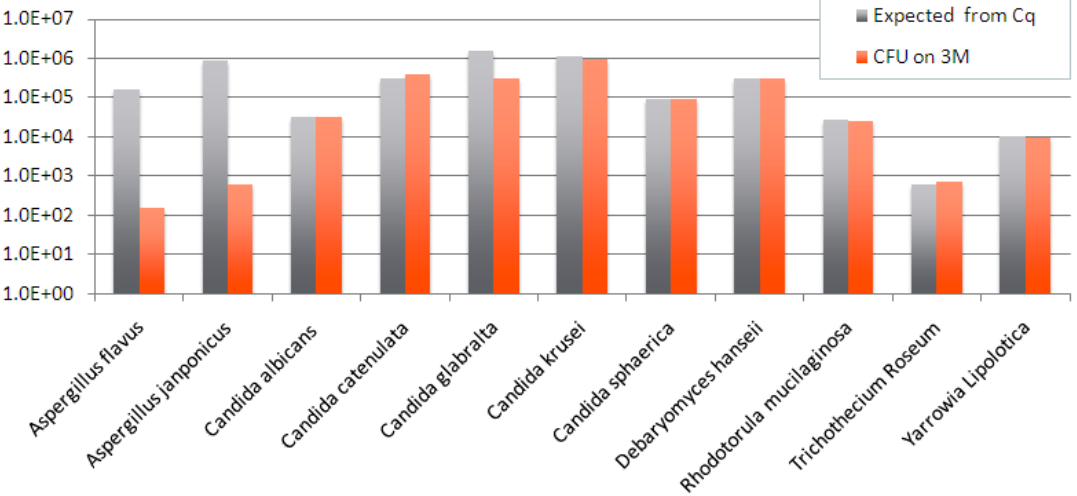
Figure 3. The following 11 species were grown at RT. Candida catenulata : ATCC 10565, Candida sphaerica : ATCC 8565, Candida krusei : ATCC 28870, Candida albicans : ATCC 10231, Candida glabralta : ATCC 15545, Yarrowia lipolytica : ATCC 18944, Rhodotorula mucilaginosa : ATCC 4557, Debaryomyces hanseii : ATCC 10623, Trichothecium Roseum: ATCC 90473, Aspergillus japonicus : ATCC 16873, Aspergillus flavus : ATCC 16870. Aspergillus demonstrates log scales lower growth at RT than most other yeast. “Expected” is the inferred CFU count from the Cq measurement using the formula CFU/g = 10 [(42.185 – Cq Value)/3.6916]